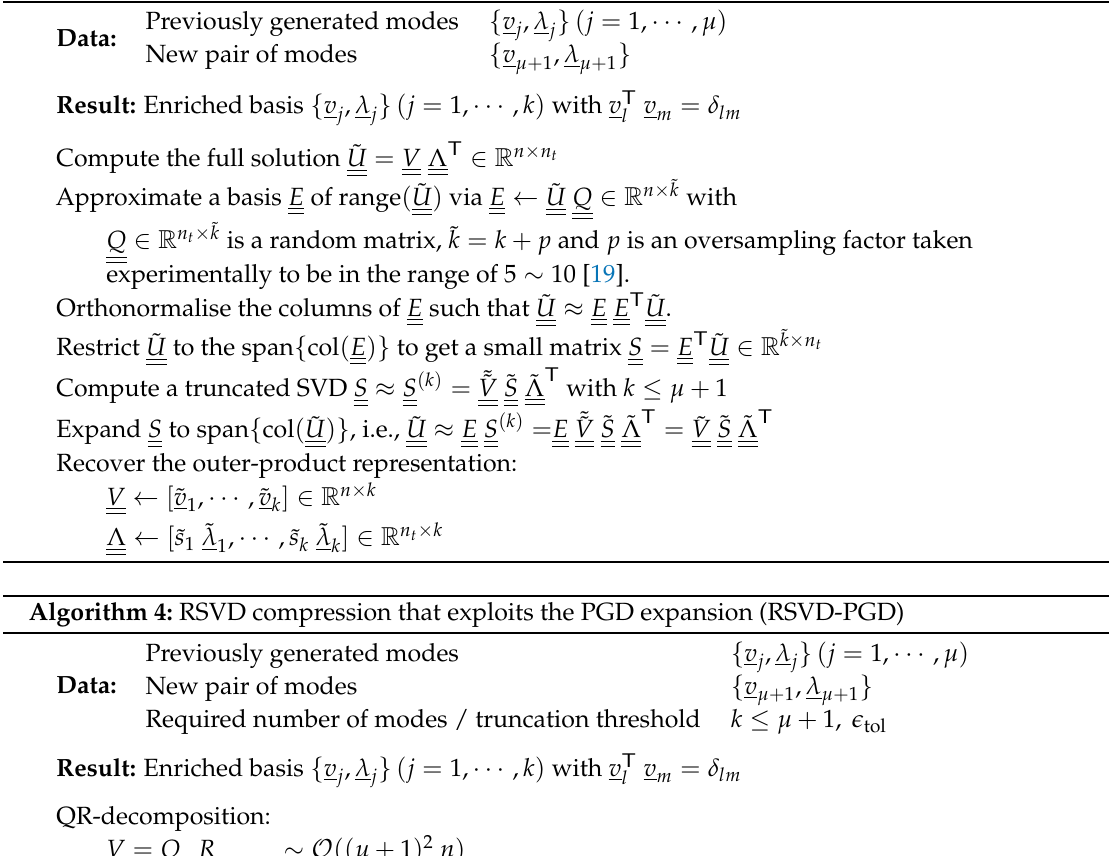
Algorithm 3: RSVD compression of a PGD expansion